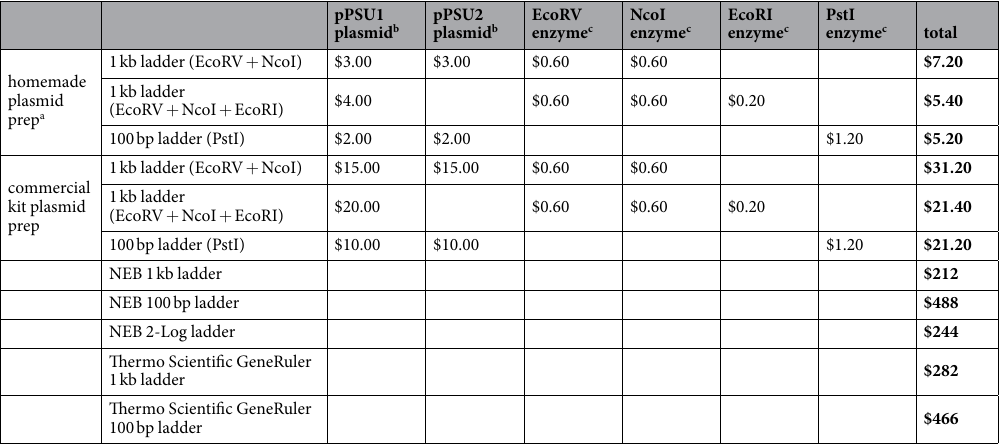
Table 2. Comparison of reagent costs to prepare DNA ladders (1000 lanes). All costs in US Dollars. a Costs including bacterial growth media and alkaline lysis plasmid prep reagents assuming 100 µ g plasmid yield for 100 ml culture. b We estimate $2.00 per our homemade 100 ml plasmid prep and $10 per midi-scale commercial plasmid prep kit. c Enzyme costs based on using New England restriction